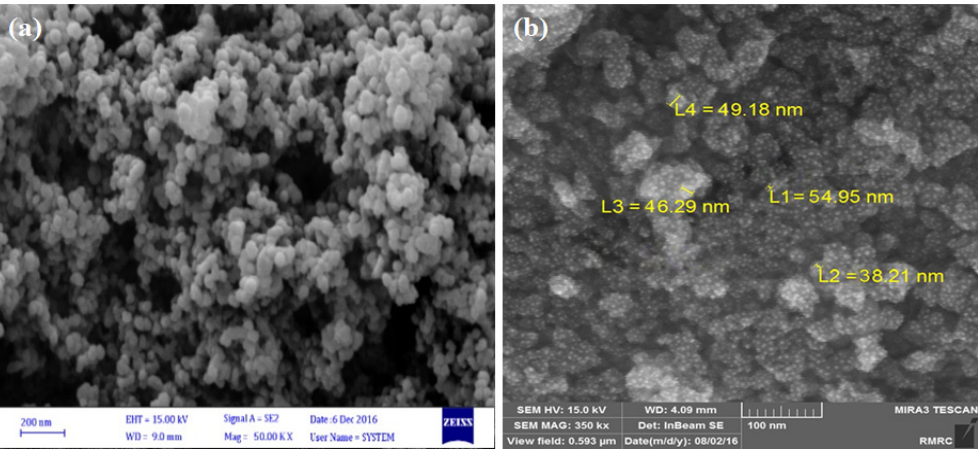
Fig. 3. SEM images of (a) TiO